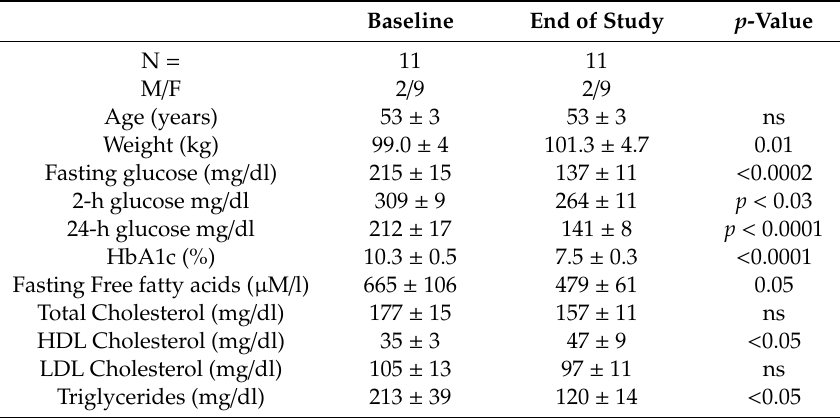
Table 1. Clinical Characteristics of Study Subjects.